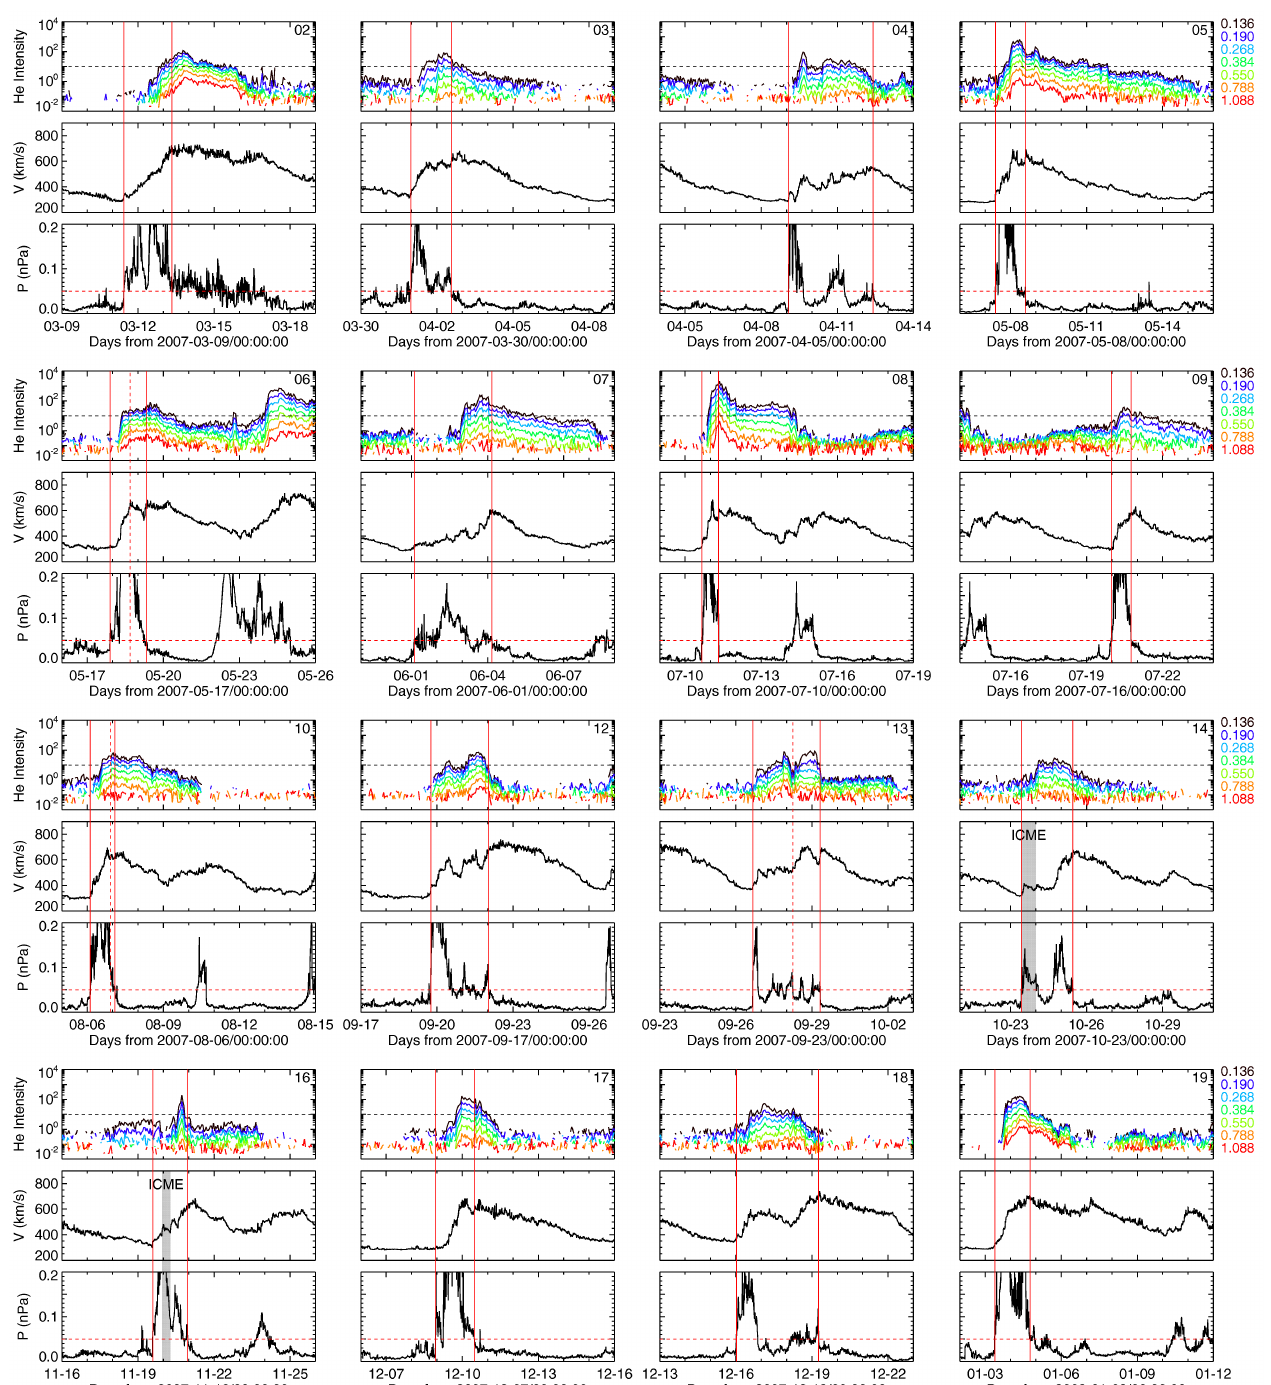
Fig. 2. Same as Fig. 1 but for STEREO-B.